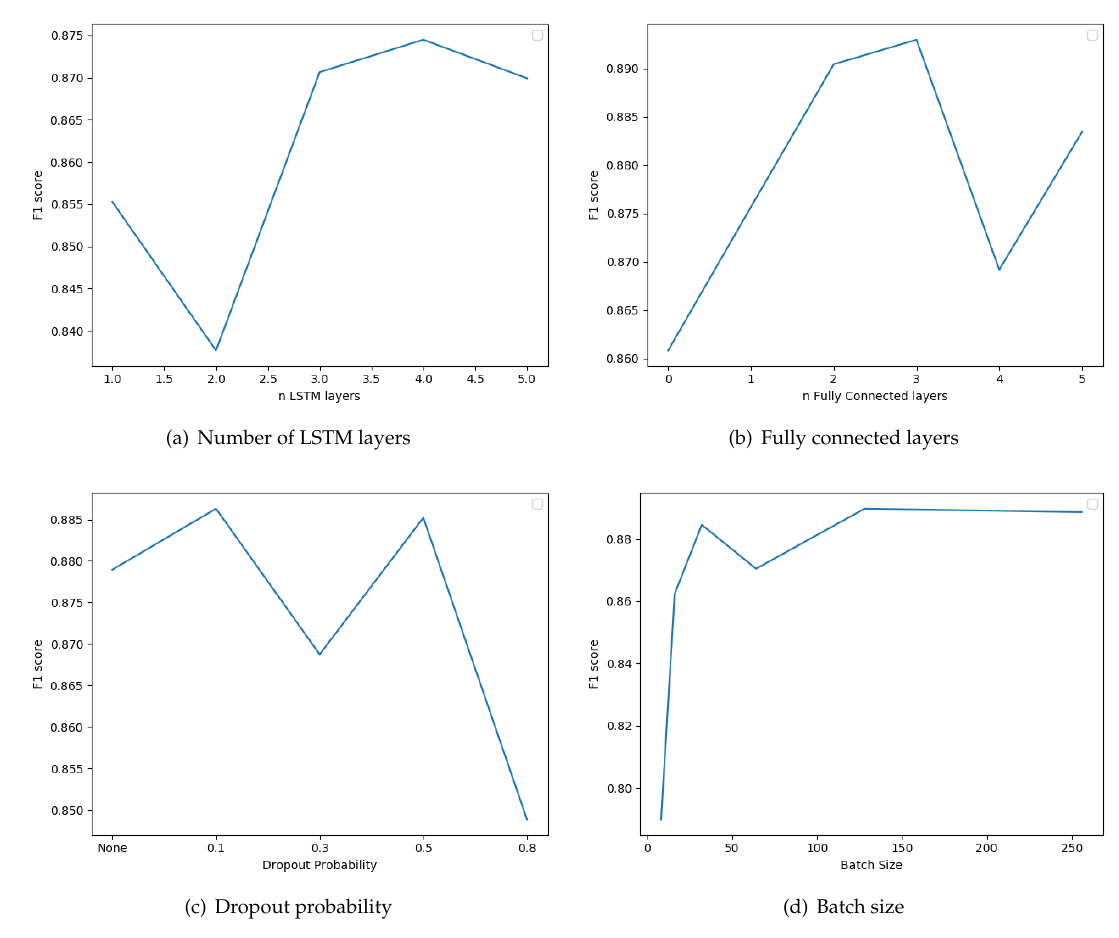
Figure 7. Evaluation of the classifier parameters regarding number of ong-short term memory (LSTM) layers, number of fully connected layers, dropout probablity, and batch size, based on the performance achieved using the average F1